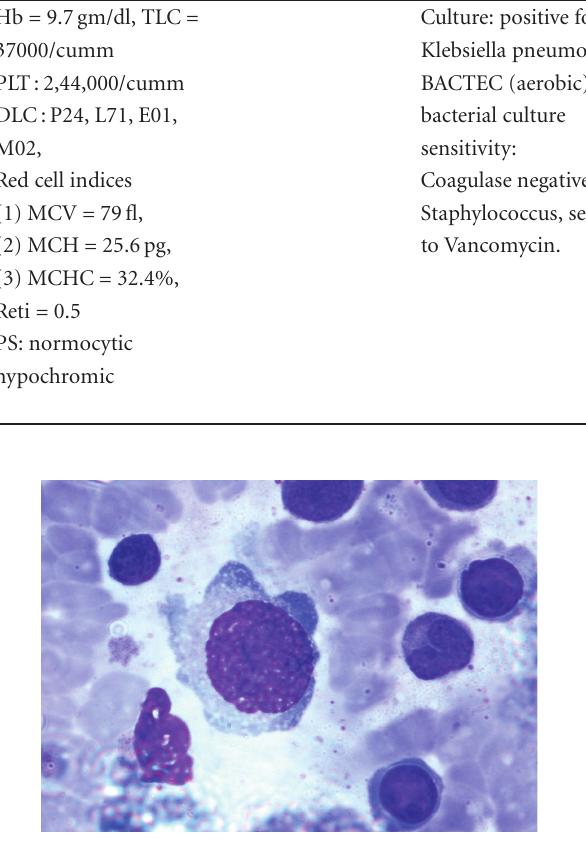
Figure 1: Bone marrow aspiration showing giant proerythroblast with prominent nucleoli and cytoplasmic blebs. Myeloid cells were relatively increased.